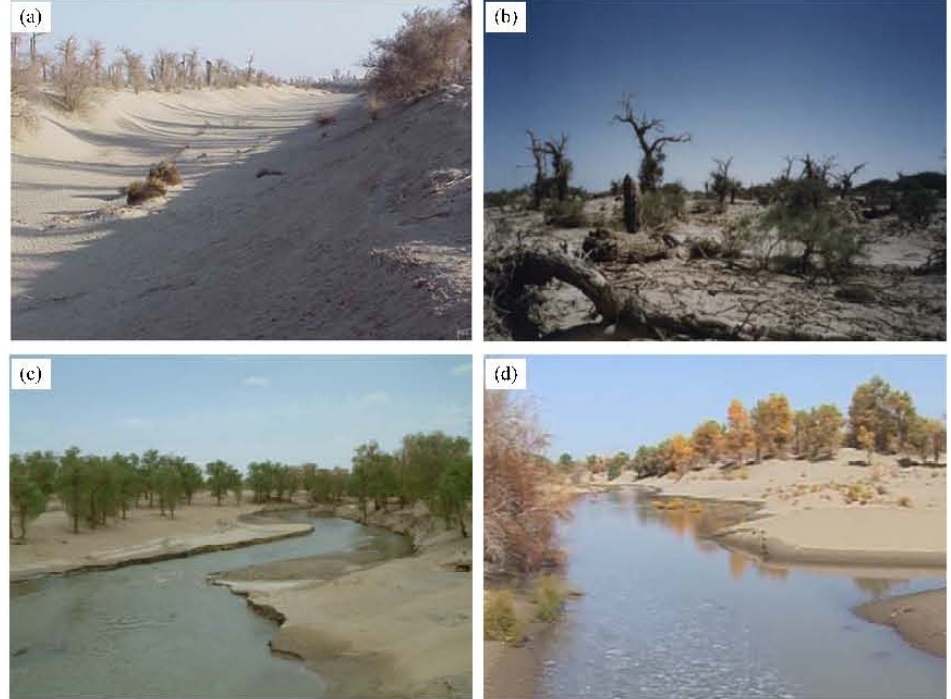
Figure 1. ( a ) Oasis desertification and natural vegetation decline in the lower Tarim River before the ecological water conveyance project (EWCP); ( b ) degenerated Populus euphratica trees; ( c ) water conveyance in summer (June, 2010); ( d ) water conveyance in autumn (October,